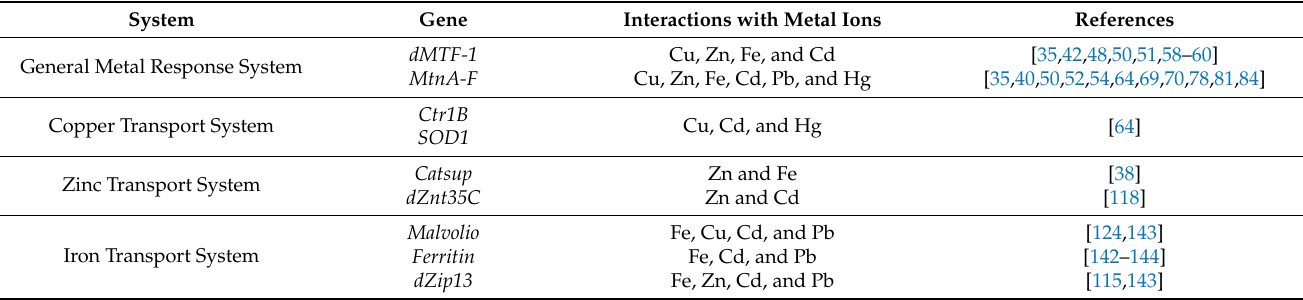
Table 1. D. melanogaster metal transport systems interacting with multiple essential and non-essential metals. System Gene Interactions with Metal